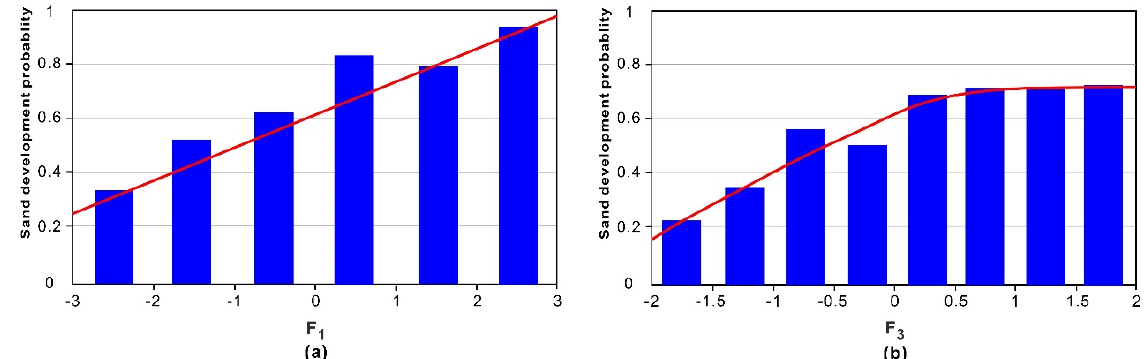
Figure 9. Calibration of sand development probability to the selected principal components F 1 and F 3 . ( a ) Calculated sand development probabilities for various classes of principal component F 1 . ( b ) Calculated sand development probabilities for various classes of principal component F 3 (The blue boxes indicate the sand development probability corresponding to different principal component values, the red line represents the fitted trend).